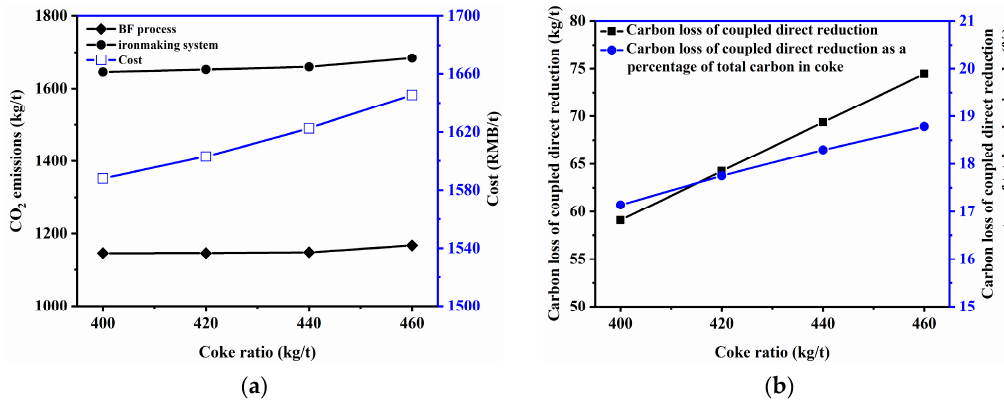
Figure 1. ( a ) Effect of coke ratio on cost and CO 2 emissions; ( b ) Effect of coke ratio on carbon loss of coupled direct reduction and its percentage of total carbon in coke.